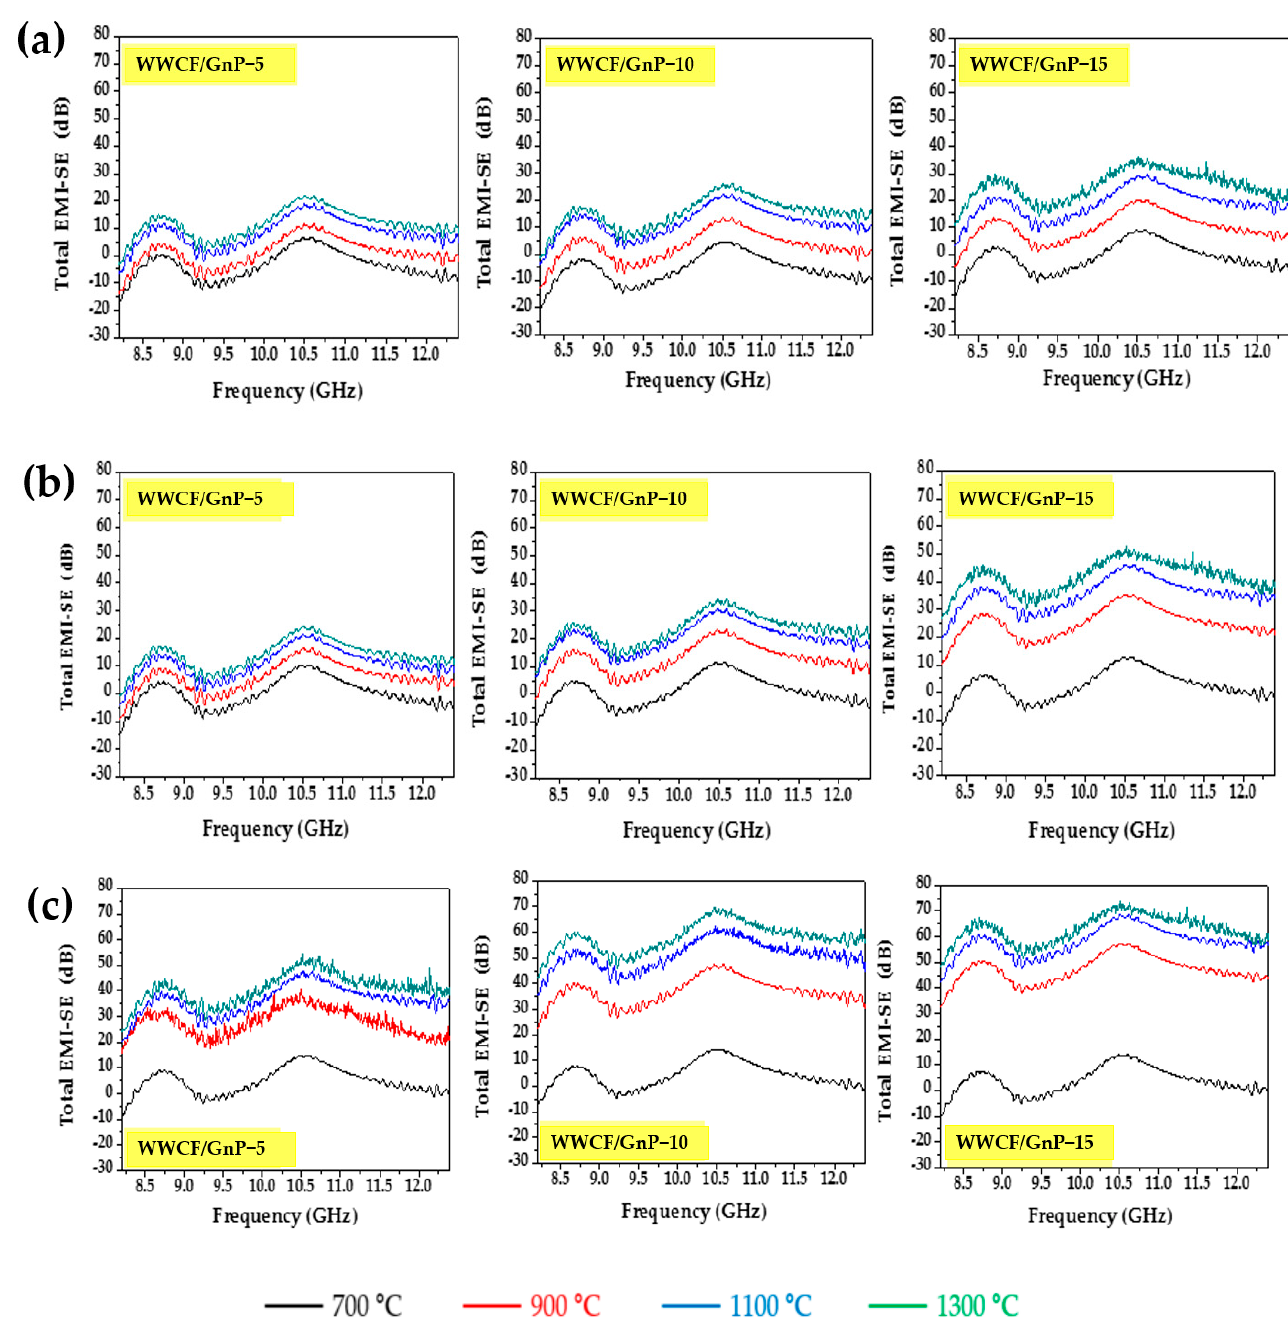
Figure 6. Electromagnetic interference shielding effectiveness (EMI SE) of waste wood cellulose fiber/graphene nanoplatelet (WWCFs/GnPs) carbon papers prepared according to the GnP contents and carbonization temperatures in the case of one sheet ( a ), two sheets ( b ), and three sheets ( c ).